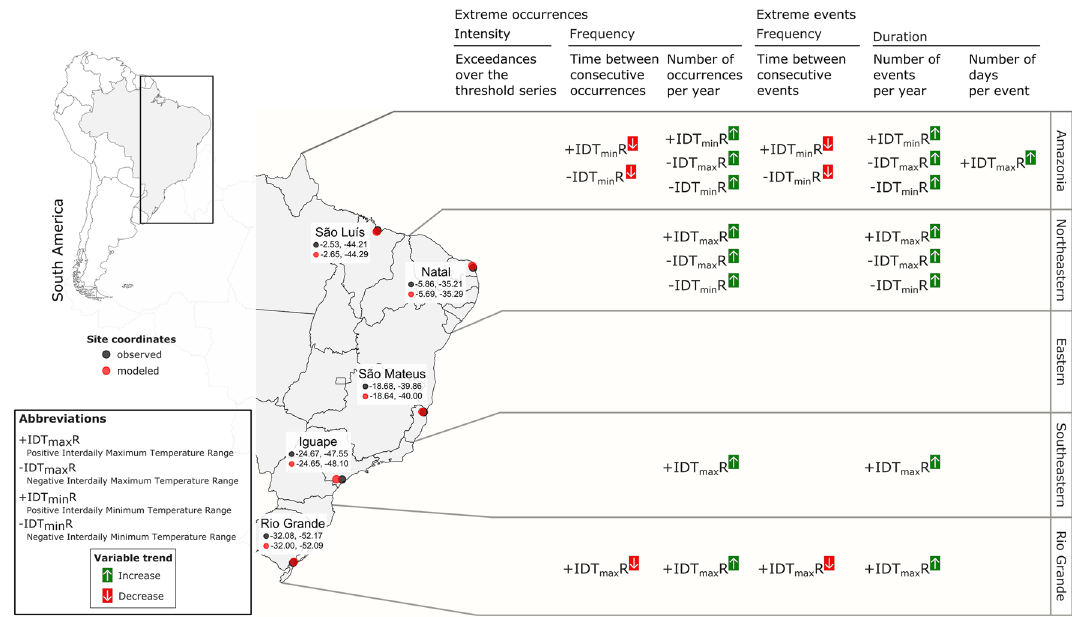
Figure 2. Overall statically significant results from trend analysis to all 5 MEOW in the last 40 years. The results are presented to the following response variables: positive inter-daily T max range (+ IDT max R); positive inter-daily T min range (+ IDT min R); negative inter-daily T max range (− IDT max R); and Negative inter-daily T min range (− IDT min R), with their respective extreme indexes that indicate intensity (Exceedances over the threshold series), frequency (both time elapsed between consecutive extreme occurrences and events, as well as the number of extremes per year), and duration (Number of days per extreme